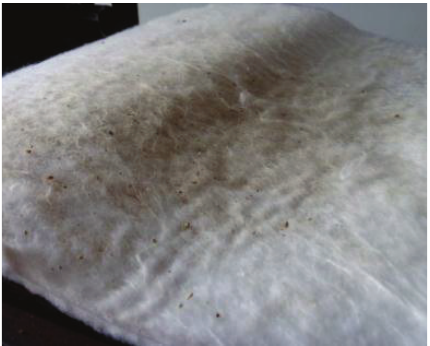
Figure 6: Ultimate surface state of CGM after